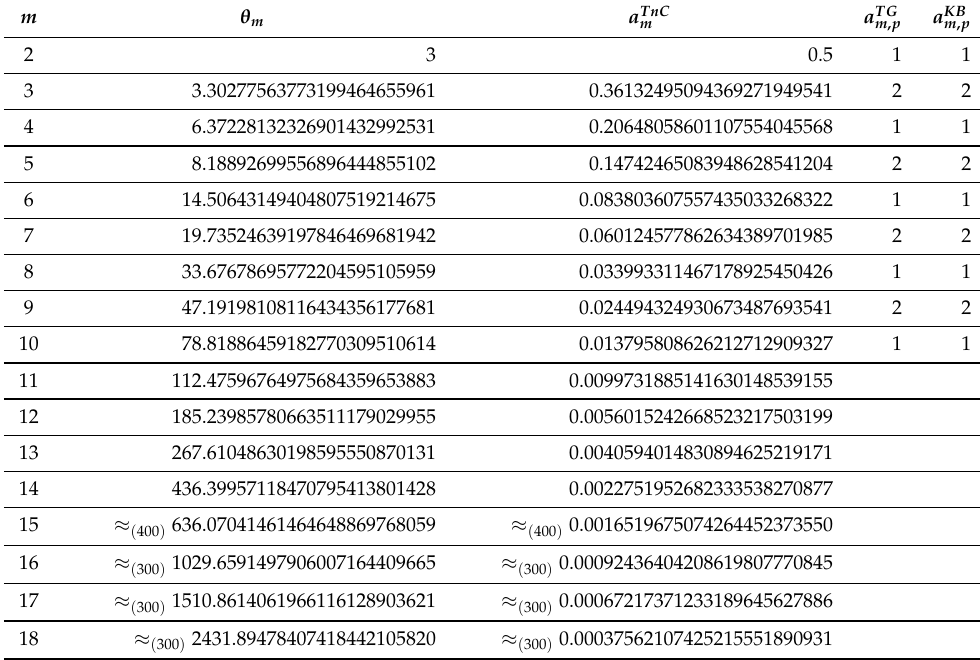
Table 5. The approximate values of θ m , a TnC m for 1 ≤ m ≤ 18 and a TG m , p and a KB m , p for 1 ≤ m ≤ 10, where ≈ ( n ) indicates the estimate based on the first n entries of the